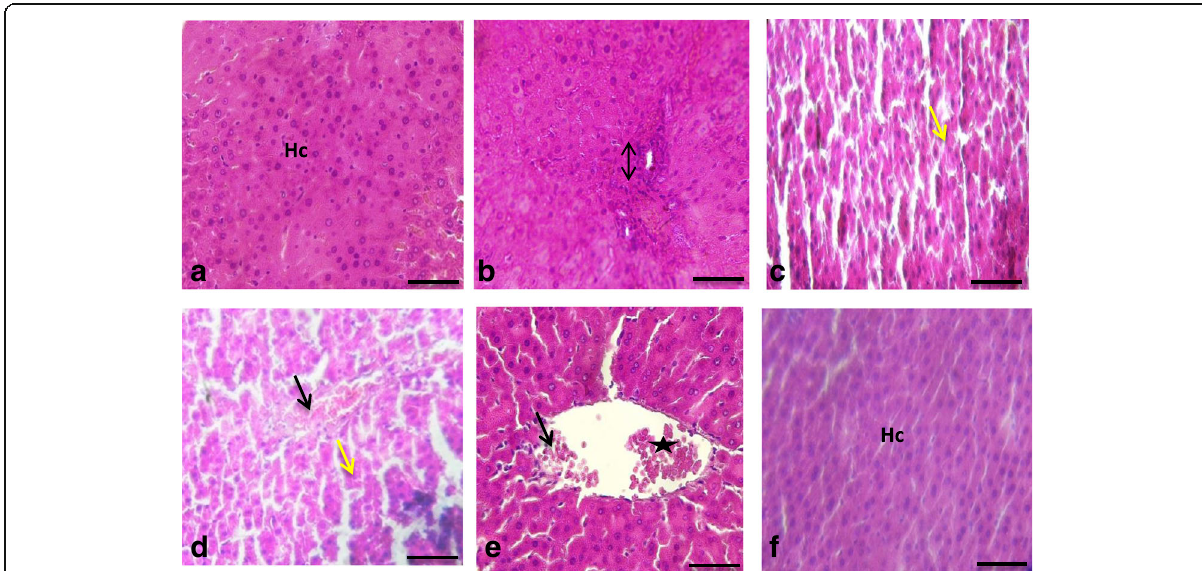
Fig. 3 Photomicrograph of H&E sections of liver of control and AE treated rats showing normal hepatic cells with well-defined nuclei and cytoplasm (Hc), normal hepatic vein(double arrow) ( a , b ). Section of Aluminum treated rat liver showing severe degenerative alterations with a necrotic anuclear hepatocytes (yellow arrows), infiltration of lymphocyte and Kupffer cells (black arrows), congestion and presence of necrotic area (*) ( c , d , e ). Section of Aluminum-AE treated rat liver showing a clear improvement compared to the control and AE groups ( f ) with a reorganization of hepatocytes structure (Hc) (H&E staining, magnification 150X and 300X, scale bar = 50 μ